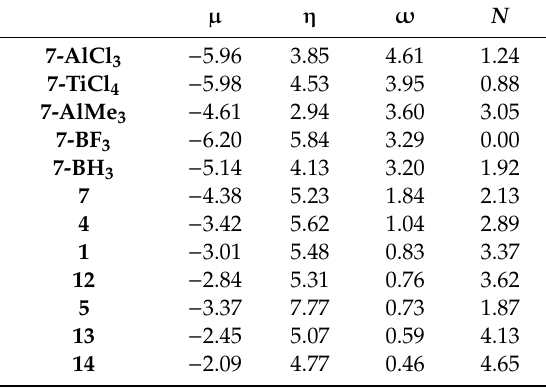
Table 1. B3LYP / 6-31G(d) electronic chemical potential µ , chemical hardness η , global electrophilicity ω , and global nucleophilicity N , in eV, for the studied